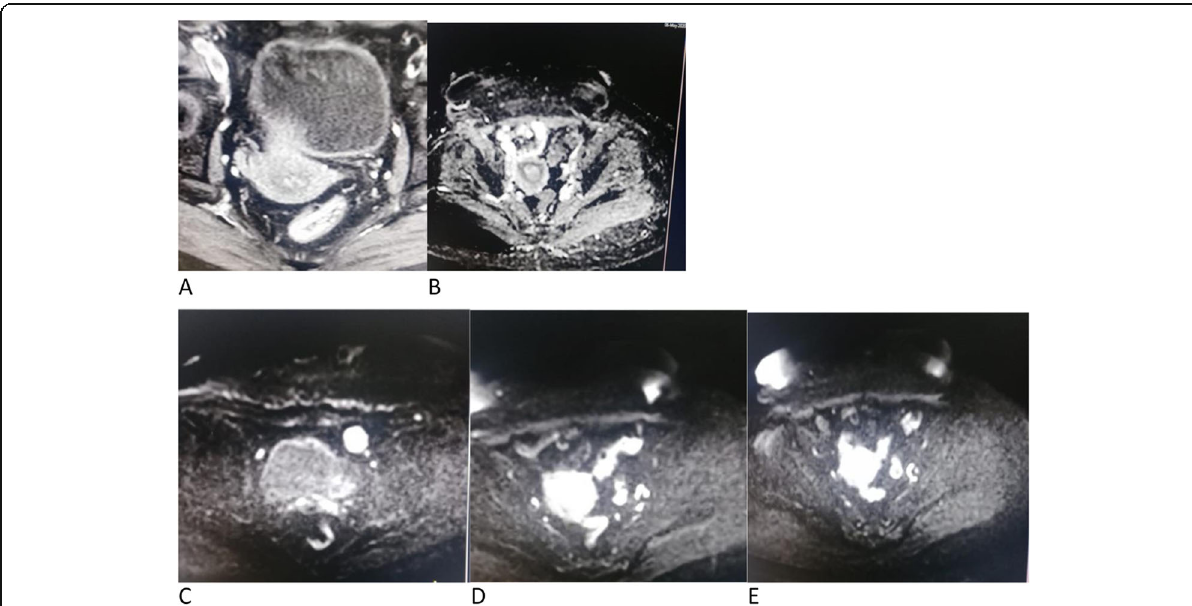
Fig. 4 A 50-year-old female patient post-operative status proved histopathologically as cervical carcinoma under treatment presented with vaginal bleeding. a Axial T2WI revealed an irregular hyperintense abnormal signal intensity lesion seen involving the operative bed as well as enlarged left external iliac LN. b Late post-contrast T1WI, the lesion showed irregular enhancement at the late post contrast study. c – e DWI, the lesion showed signal intensity restriction with high b value (800) as well as hyperintense left external iliac LN with the corresponding low signal at ADC map. Diagnosis: recurrent cervical